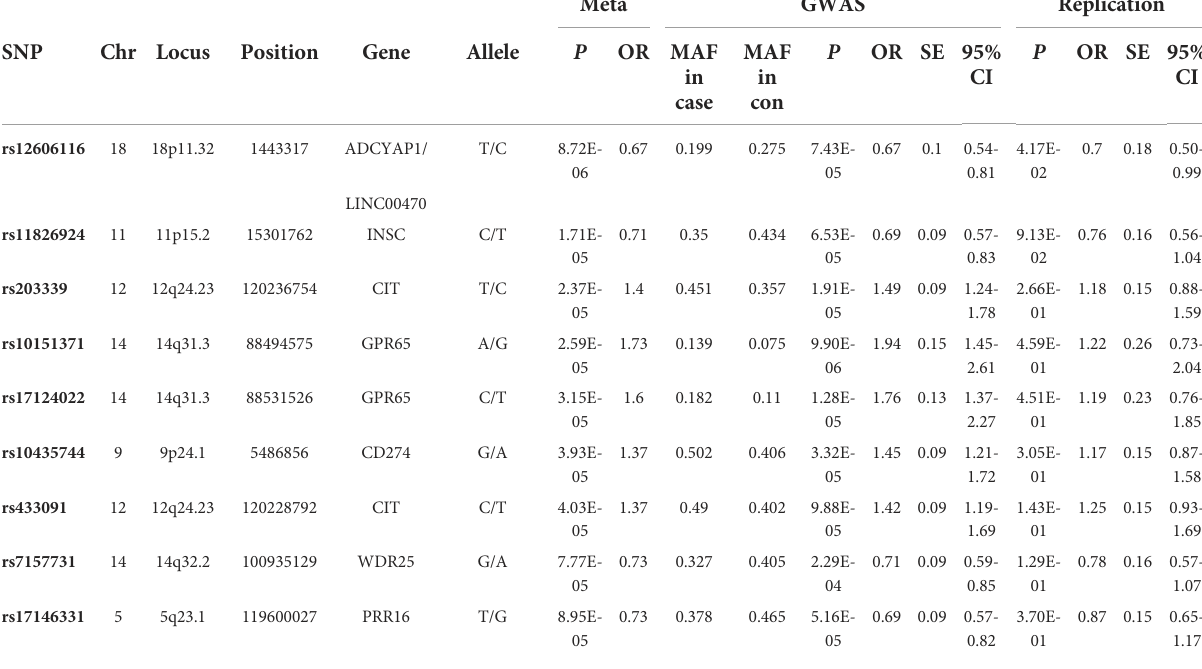
TABLE 2 Summary results of 9 SNPs in the GWAS, replication and meta-analysis. Meta GWAS Replication